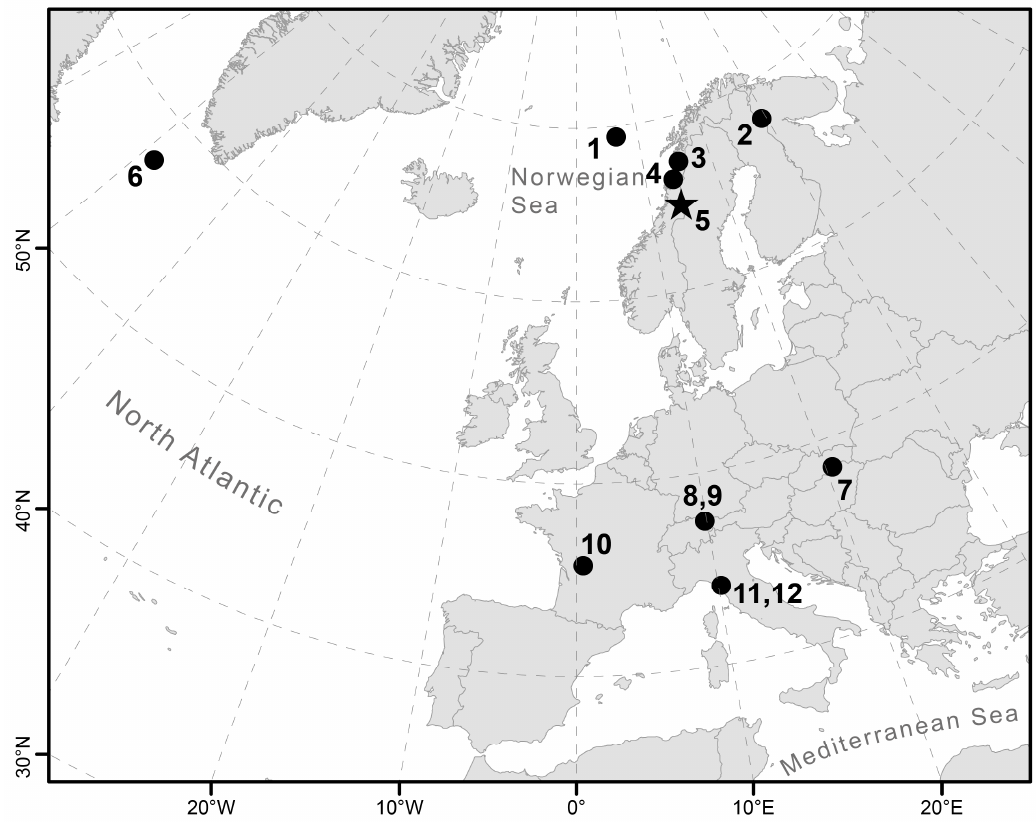
Figure 1. Map showing the location of Korallgrottan (#5, marked by a star) and sites mentioned in the